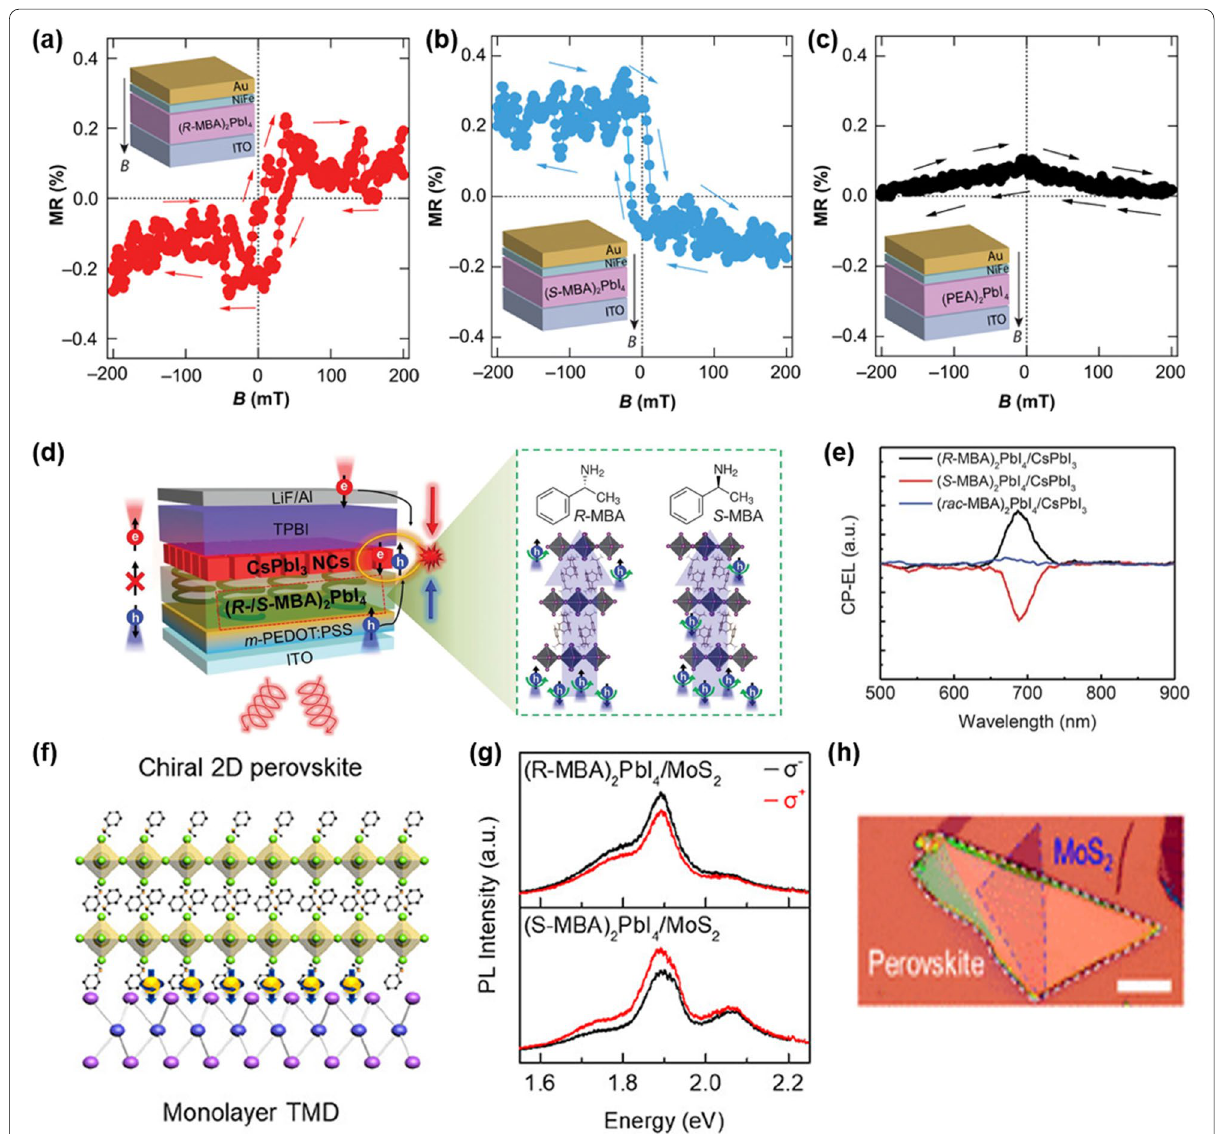
Fig. 4 Magnetoresistance response of spintronic devices. a ( S -MBA) 2 PbI 4, b ( R -MBA) 2 PbI 4 , and c nonchiral HOIPs. Reproduced with permission from [37]. Copyright 2019 AAAS. d Schematic description of CP-EL emission by spin polarization in the spin-LEDs. e The CP-EL spectra of chiral